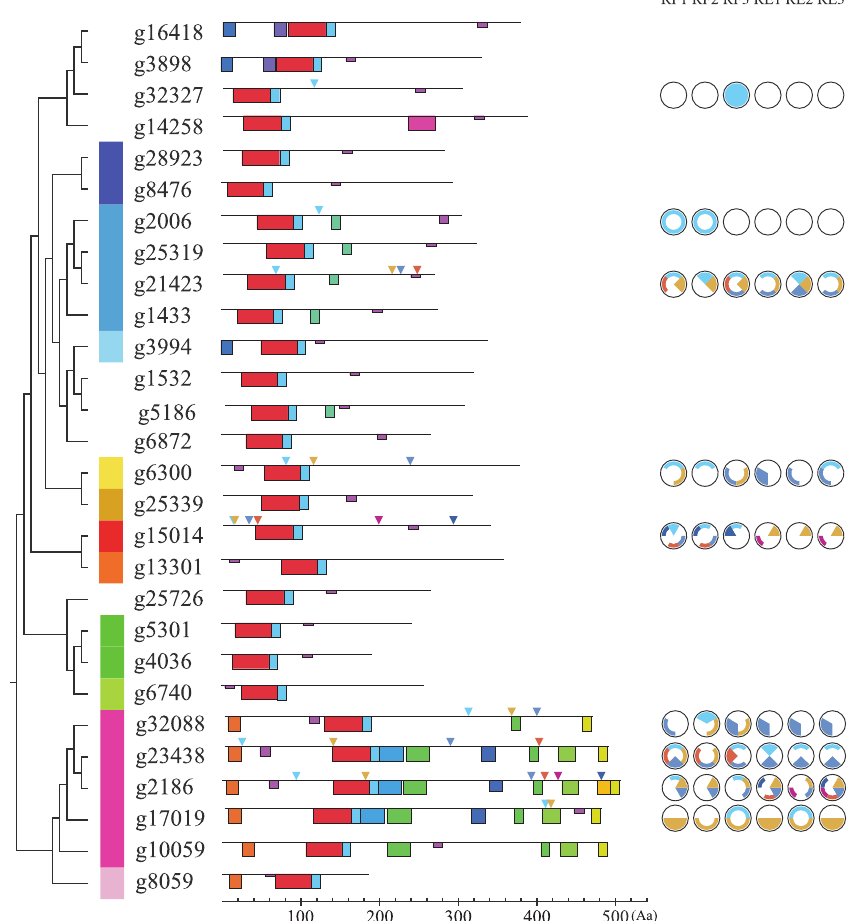
Figure 3. Conserved protein motifs and SNPs from Eugenia uniflora DOF genes. The phylogenetic relationships between DOF genes are shown on the left. Colored boxes represent protein motifs. Black lines represent protein sequences without annotated motifs. Triangles indicate identified SNPs locations. On the right, a comparison of SNPs between the two populations is shown. Filled slices represent homozigote polymorphisms and outlined slices heterozigotes